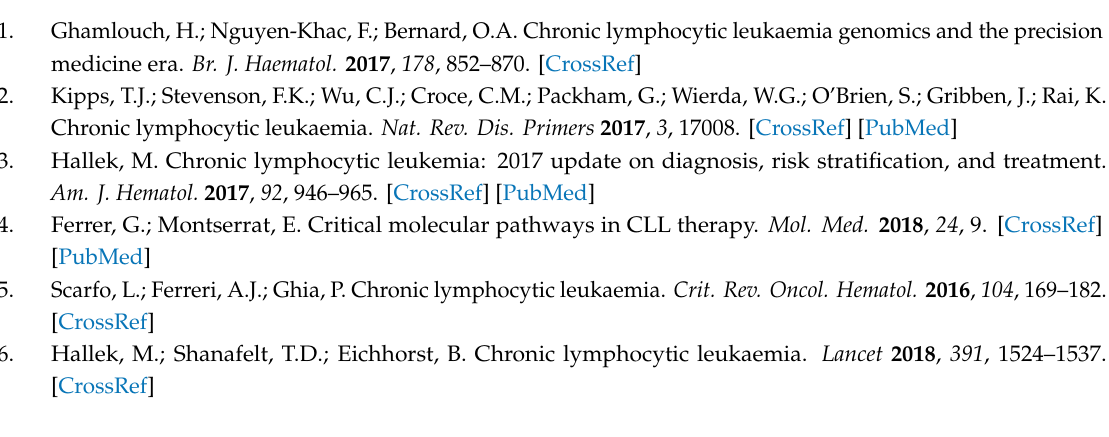
s1, Figure S1: Levels of sAPRIL in groups of CLL patients according to the Rai stage, Figure S2: In silico analysis—rs3803800 of TNFSF13 , Figure S3: In silico analysis—rs4968210 of TNFSF13 , Figure S4: Analysis of potential e ff ects of rs11078355 A > G on splicing of TNFRSF13B gene, Figure S5: In silico analysis—rs11078355 of TNFRSF13B , Figure S6: In silico analysis—rs4985726 of TNFRSF13B , Table S1: Genotype distribution of the APRIL ( TNFSF13 ; 17p13.1) polymorphisms in patients and controls, Table S2: Genotype distribution of the TACI ( TNFRSF13B ; 17p11.2) polymorphisms in patients and controls, Table S3: Average values of APRIL MFI in CD19 + CLL cells in relation to APRIL SNP genotypes, Table S4: Average percentage of CD19 + APRIL + CLL cells according to APRIL SNP genotypes, Table S5: Average levels of plasma sAPRIL according to APRIL SNP genotypes, Table S6: ANOVA table with linear contrast for IgA levels [g / l] in CLL patients according to rs3803800G > A genotype, Table S7: ANOVA table with linear contrast for CD19 + TACI + percentage according to Rai stage. Table S8: Genotype distribution of the BCMA ( TNFRSF17 ; 16p13.13) polymorphisms in patients and controls, Table S9: Basic statistics of the main variables considered in the paper, Table S10: Primer sequences, annealing temperatures and restriction enzymes used for PCR-RFLP genotyping, Table S11: TaqMan SNP Genotyping Assays used for genotyping with applying the allelic discrimination method, Supplementary Data 8: Prediction of functional e ff ects for: TNFSF13 rs3803800G > A, rs4968210G > A and TNFRSF13B rs4985726C > G and rs11078355A >